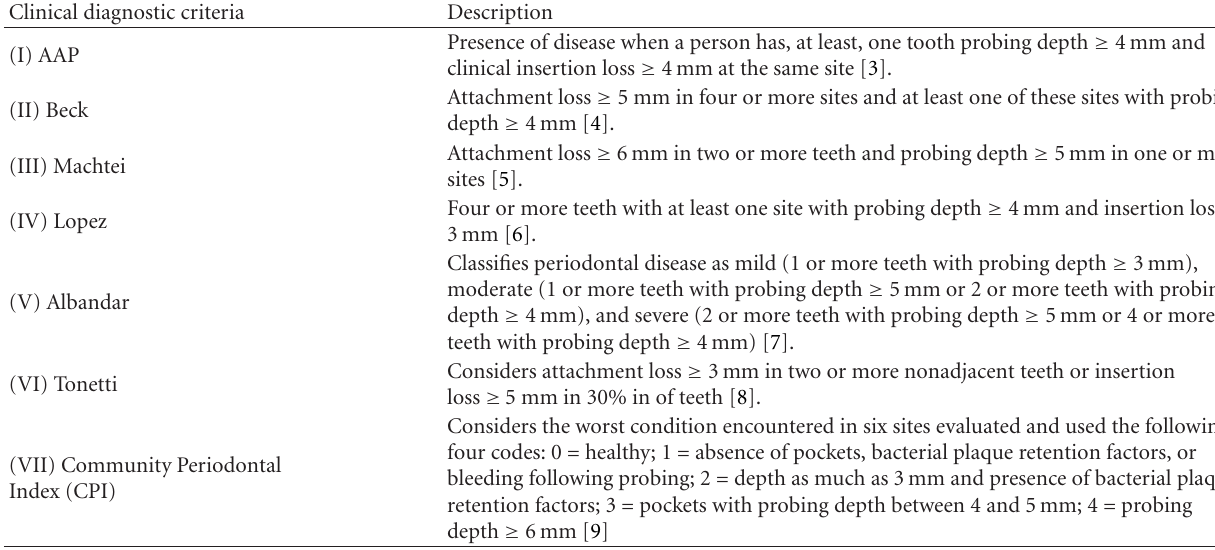
Table 1: Description of clinical diagnostic criteria for periodontal disease.